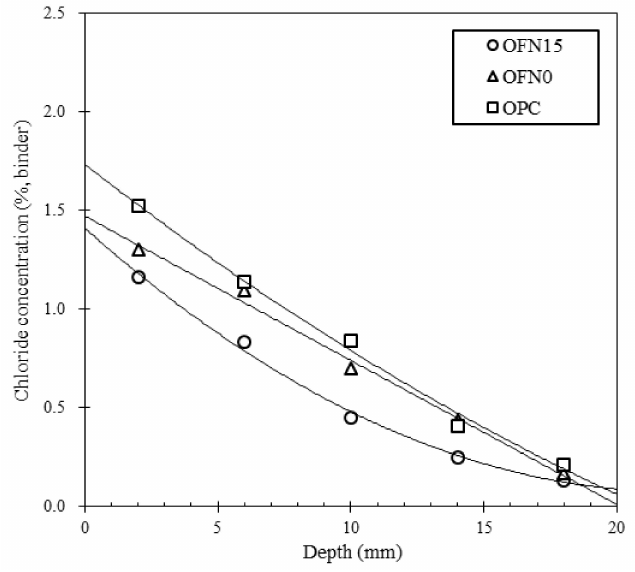
Figure 7. Chloride profile at each